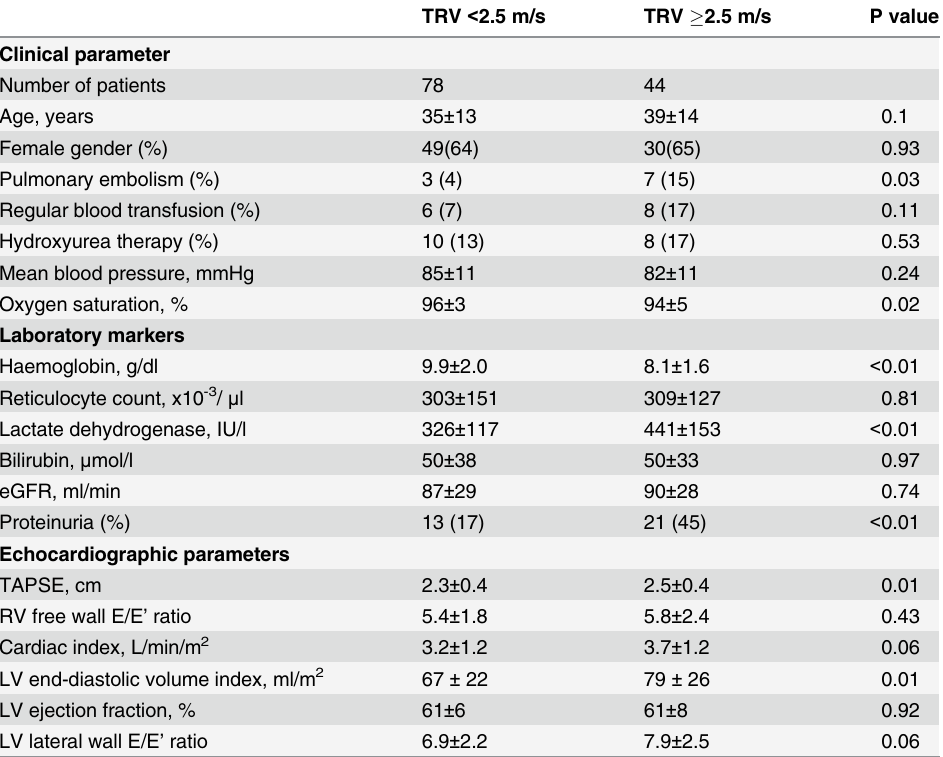
Table 3. Clinical, laboratory and echocardiographic parameters for patients divided according to TRV < 2.5 and (cid:1) 2.5 m/s. eGFR, estimated glomerular filtration